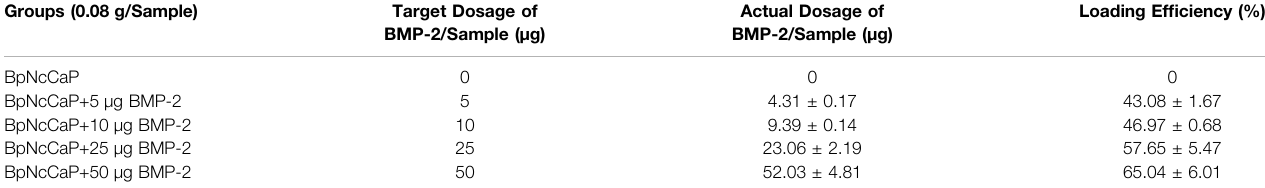
TABLE 1 | The group set-up with the target dosage, actual dosage and corresponding loading ef fi ciency of BMP-2 in the BpNcCaPs. Groups (0.08 g/Sample)